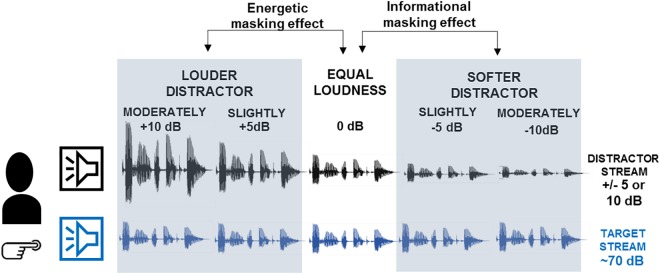
Schematic illustration of the experimental design. Participants listened to two concurrent speech streams presented from two spatially separate loudspeakers. The left stream (labeled by the blue loudspeaker) was designated as the target on which participants performed the numeral-detection and the content-tracking task. The right stream (labeled by black loudspeaker) served as distractor. The amplitude of the speech signals illustrates the loudness of the two speech streams in the different conditions. Based on the loudness difference between the target and distractor streams, five conditions were presented: moderately louder distractor, slightly louder distractor, equal loudness, slightly softer distractor, moderately softer distractor. The gray-shaded panels mark the expected impacts of the loudness difference: informational masking effects have been tested by comparing across the slightly and moderately softer distractor and the equal loudness conditions, whereas energetic masking effects across the slightly and moderately louder distractor and the equal loudness conditions.